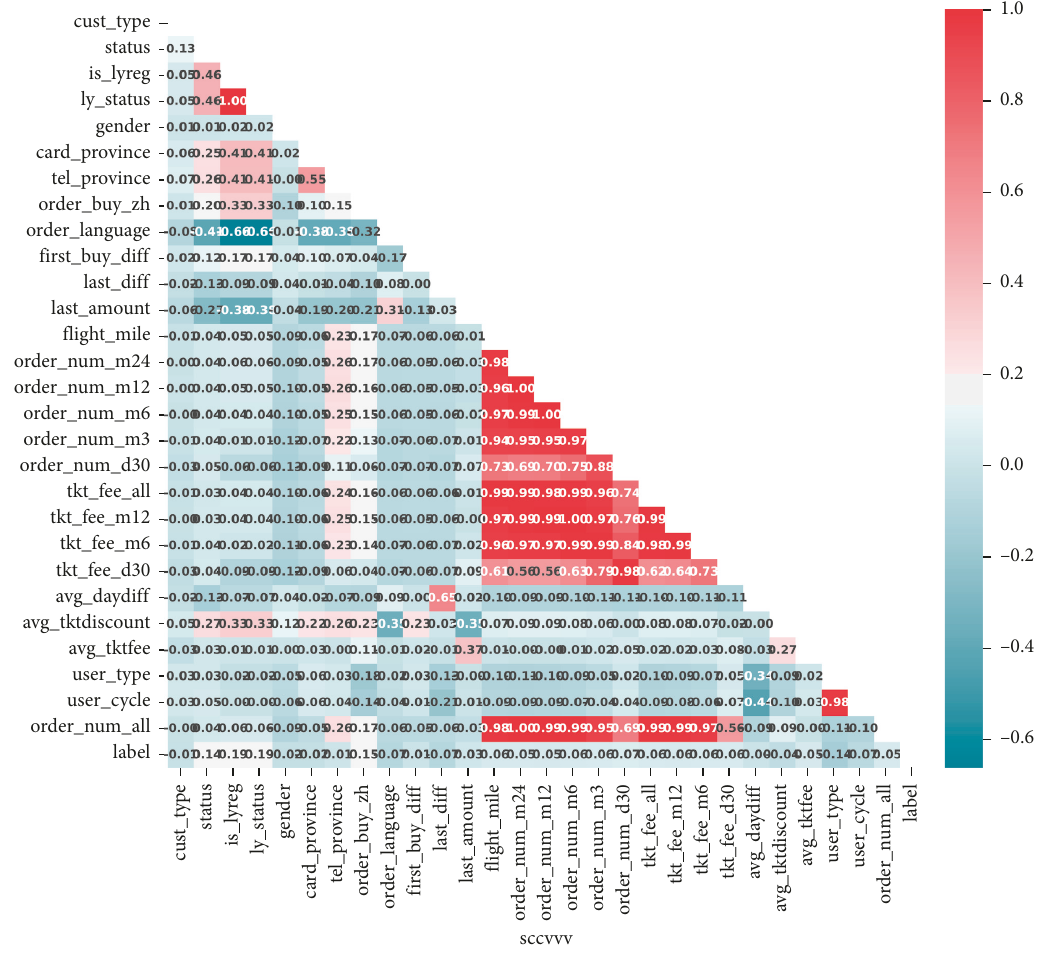
Figure 3: Correlation coefficient matrix.